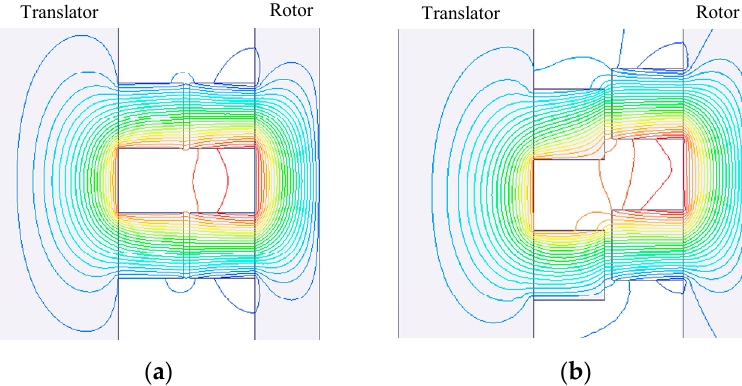
Figure 4. Magnetic field distribution. ( a ) Stable state (aligned position), ( b ) unstable state (displaced axially by 3/5 pole pitch).